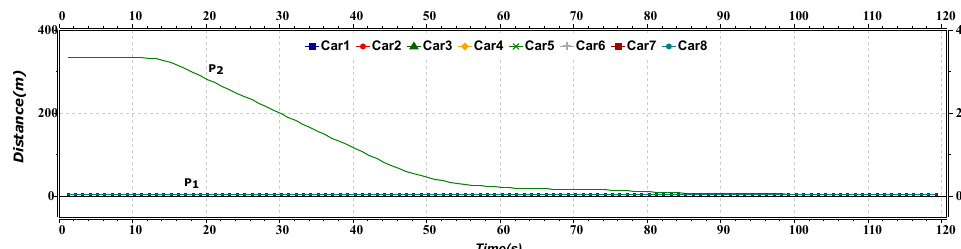
Figure 4. Speed versus time graph of merge maneuver. Figure 5 represents the distance versus time of the merge maneuver of the platoon. The graph shows the distance between both the platoons. Initially, both the platoons have an inter-platoon distance of approximately 330 m. After approximately 12 s, as the rear platoon leader increases its speed, and the distance between the platoon starts decreasing. After nearly 80 s, all the AVs have a constant distance between them as both platoons merge to form one platoon.